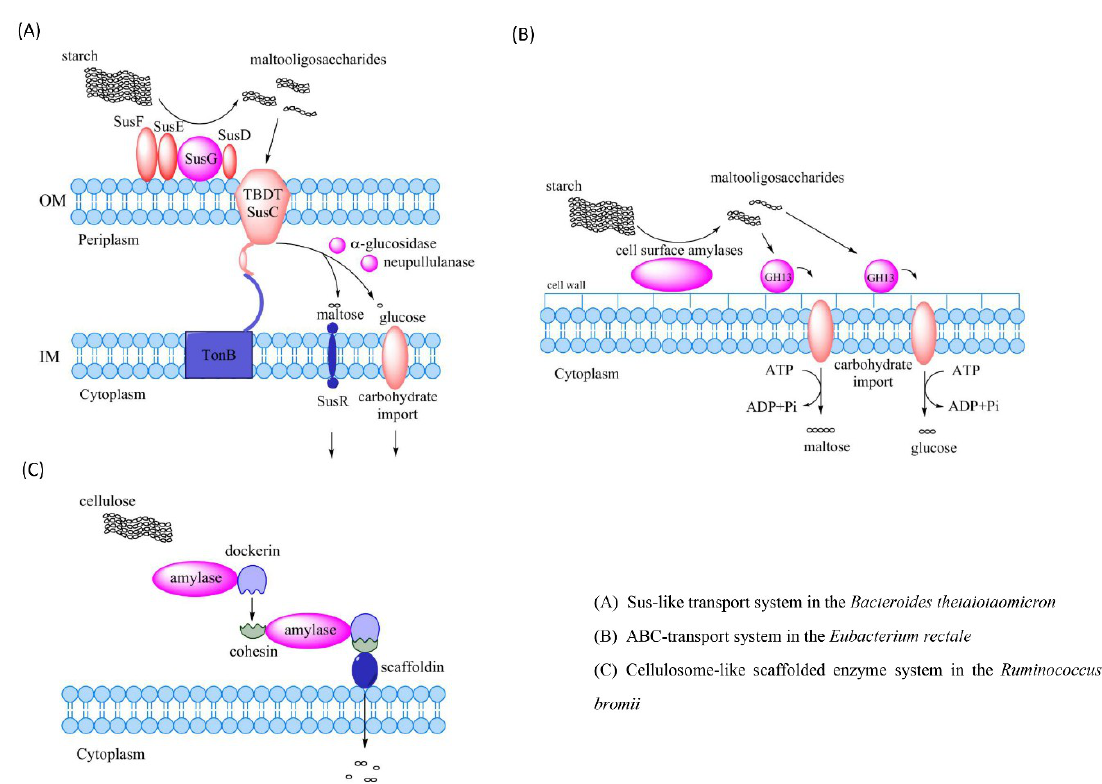
Figure 3. Mechanisms of the polysaccharide degradation by intestinal bacteria. ( A ) Starch utilization system (Sus) in the Bacteroides thetaiotaomicron , which degrades starch into maltooligosaccharides via SusG. Maltooligosaccharides are transported into periplasm by TBDT SusC through SusD, SusE and SusF and are degraded into maltose and glucose that are imported into the cytoplasm. ( B ) ABC transport system in the Eubacterium rectale degrades starch into maltooligosaccharides through cell surface amylases. Maltooligosaccharides are recognized by two separate ABC transport solute-binding proteins and then carried into the cytoplasm. ( C ) The cellulose-like scaffolded enzyme system in the Ruminococcus brings the cellulose and enzymes together on the cell surface via the dockerin-cohesion protein to degrade celluloses into monosaccharides. Abbreviations: OM, outer membrane; IM, inner membrane; TBDT, TonB-dependent transporter; GH13, glycoside hydrolase family 13; Sus, starch utilization system; ABC, ATP-binding